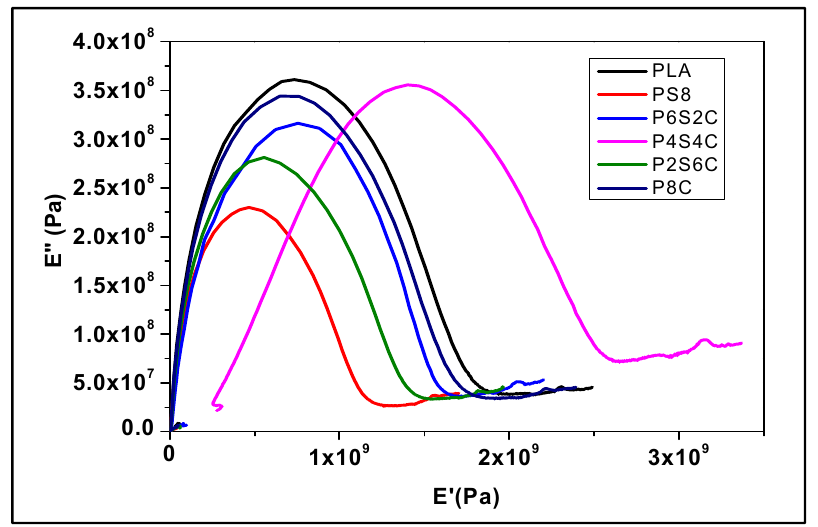
Figure 6. Cole–Cole plots of biocomposites with different starch—amphiphilic chitin